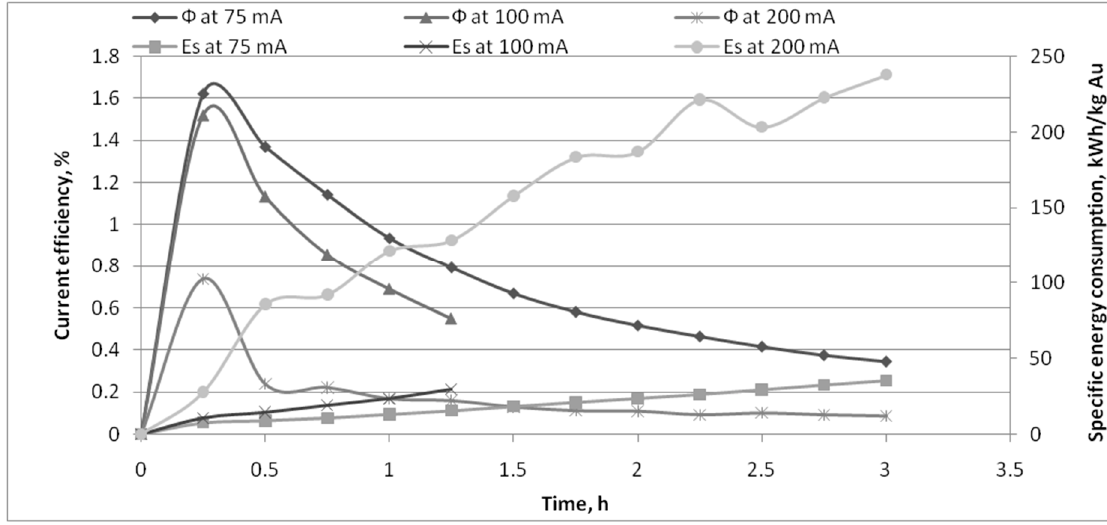
Figure 7. Current efficiency and specific energy consumption at different current intensity vs. time for Au.